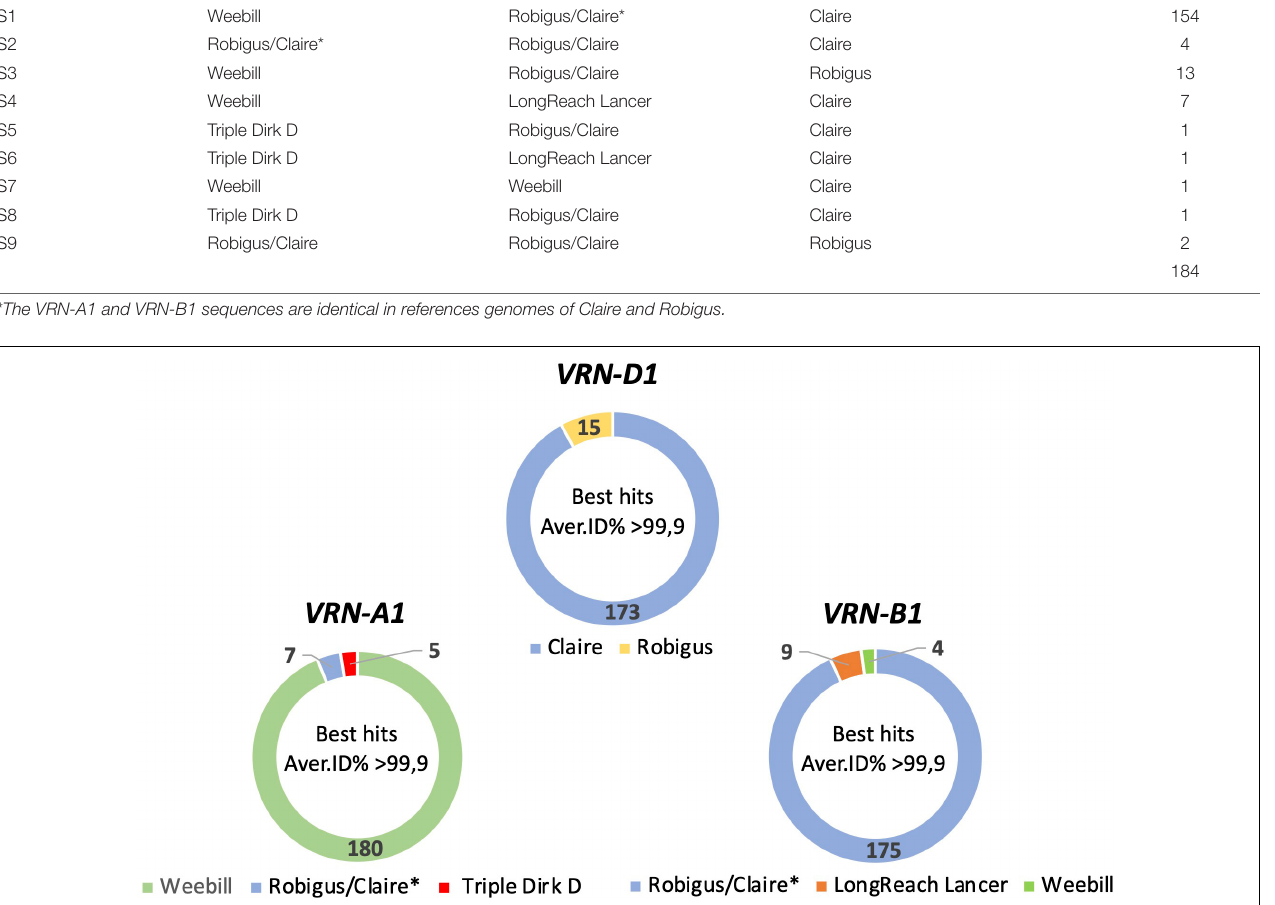
TABLE 1 | Grouping of 184 wheat cultivars based on top BLASTn hits of full-length VRN1 sequences against around 30 reference genomes reveal nine groups of A, B, and D homeolog sequence combinations most similar ( > 99.9%) to only five reference genomes. VRN1 VRN-A1 best full-length hit VRN-B1 best full-length hit sequence type with reference with reference